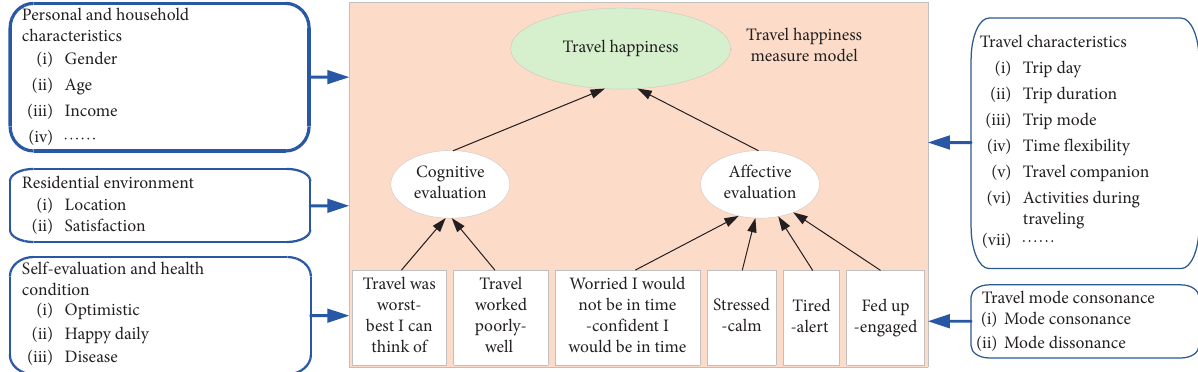
Figure 1: Research